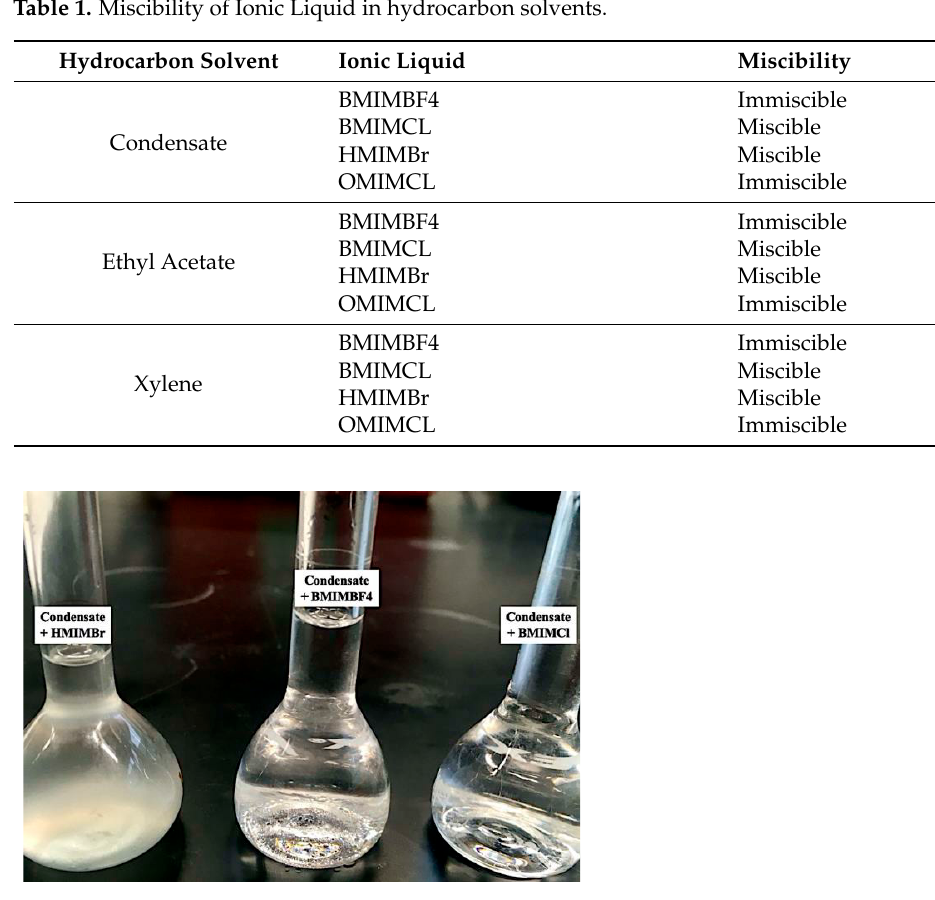
Figure 3. Example of miscibility of ILs in condensate.